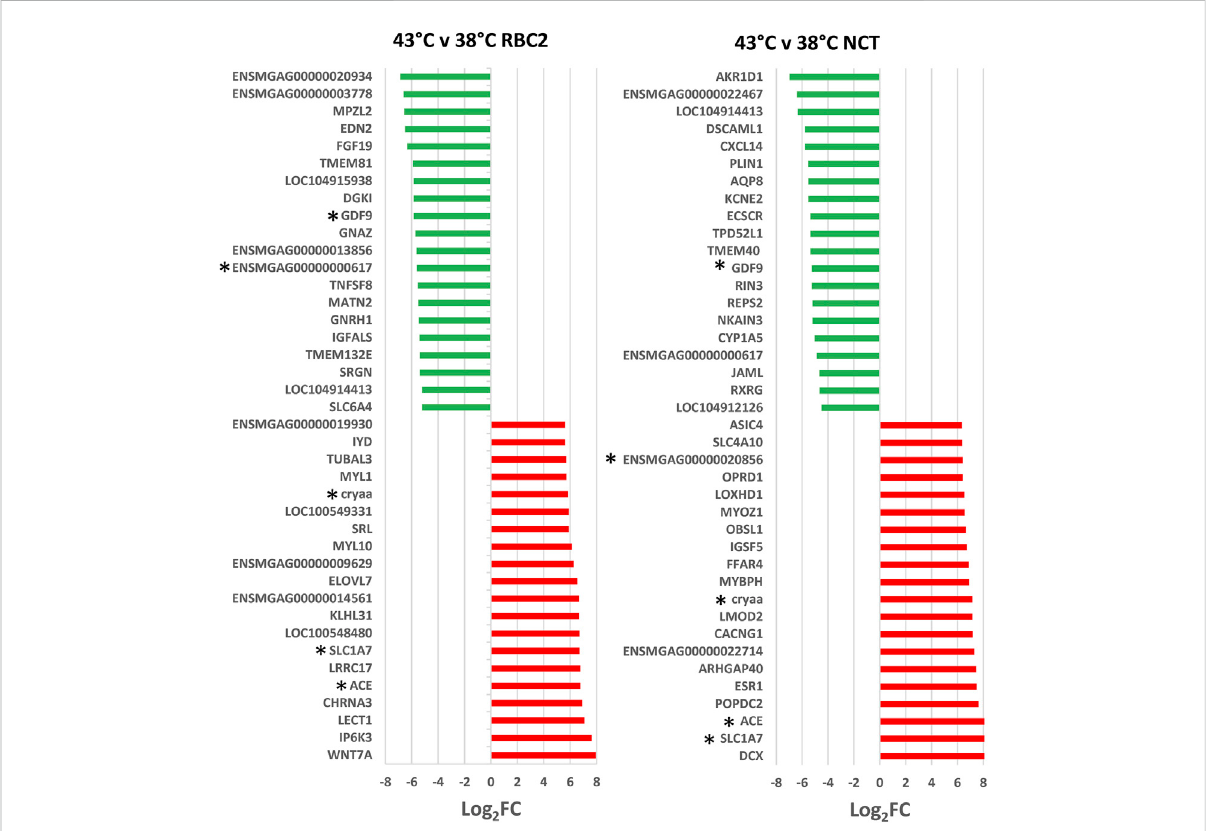
FIGURE 3 Directional change in the genes showing the highest expression differences between lines (NCT and RBC2) at 38 and 43 ° C. For each with-in temperature comparison the Log 2 FC for each gene is plotted (FDR pval < 0.05). Genes shared between temperatures are indicated by